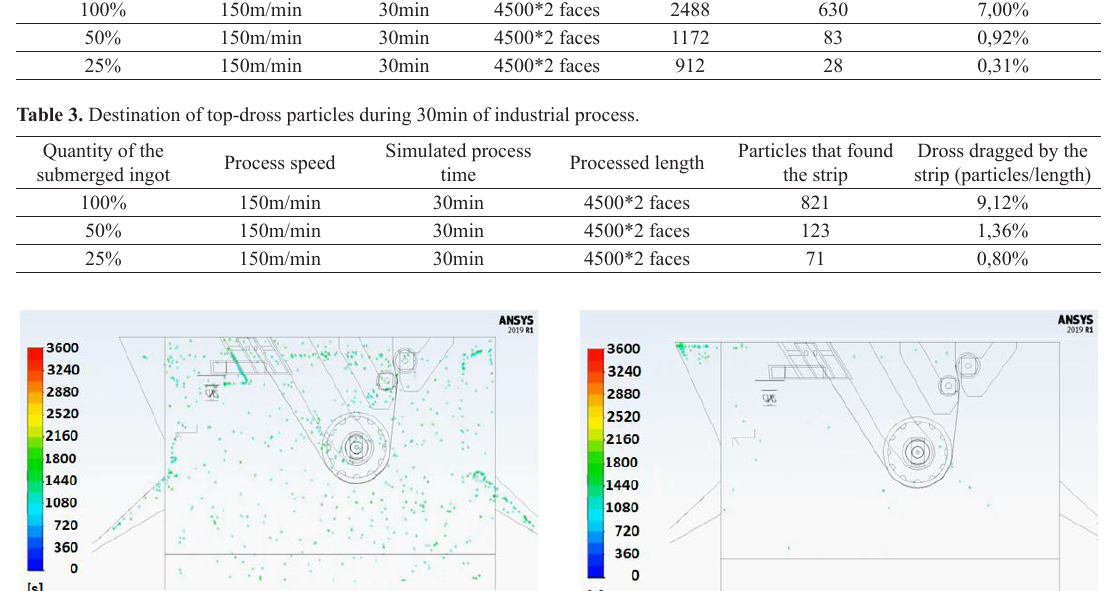
Table 2. Destination of top-dross particles simulating 30-minute process. Quantity of the submerged ingot